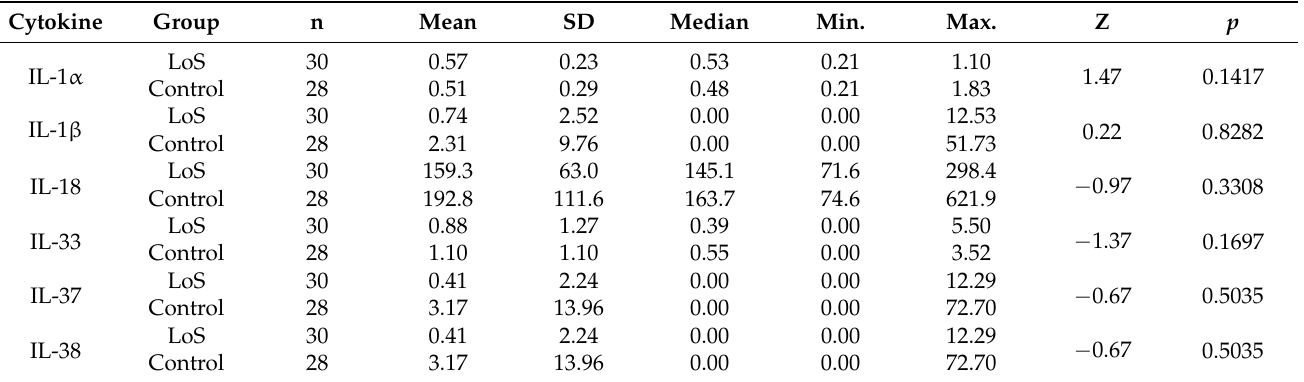
Table 4. Comparison of baseline (before systemic and topical or only topical treatment) cytokines concentrations in LoS patients and HCs.